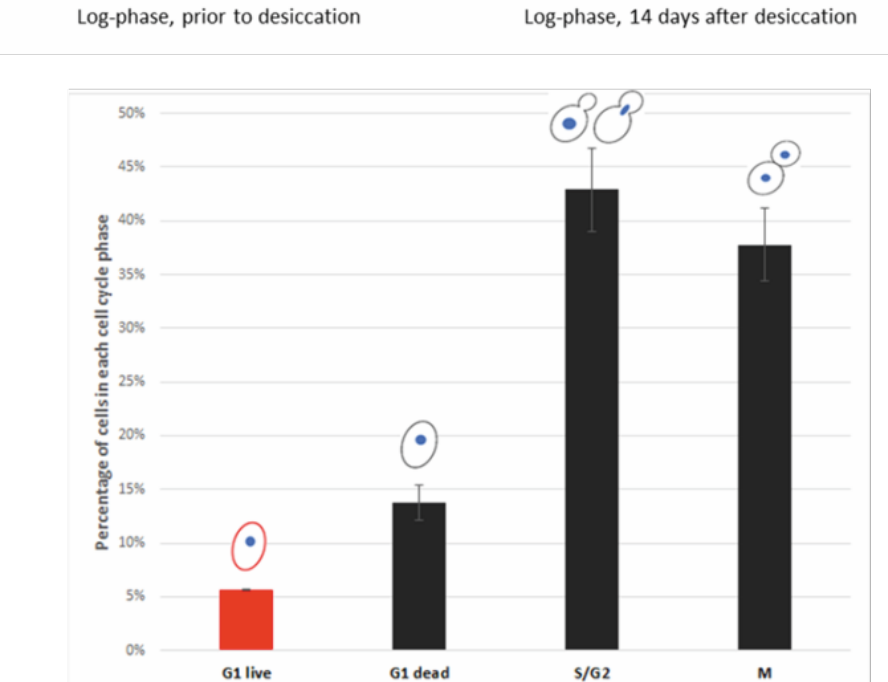
FIGURE 1. (A, B) Flow cy- tometry analysis of expo- nential cells (overnight cul- ture) prior to (A) , and 14 days after (B) desiccation. Cells were fixed with 70% ice cold ethanol, stained with propidium iodide (PI) Cell Cycle solution, and analyzed using an Bio-Rad S3e cell sorter. Arrow indicates the small population of cells that had higher DNA content. 1n and 2n indicate one copy and two copies of DNA, respectively. (C) Percentage of live/dead cells in different cell cycle phases of expo- nential cells after 14 days of desiccation. Live and dead cells were identified by PI staining. Cell cycle status was determined by images of bright field and fluores- cence brightener-28 stained cells. Approximately 400 cells were counted from each experiment and the data were presented as mean ± standard error from three independent experi-